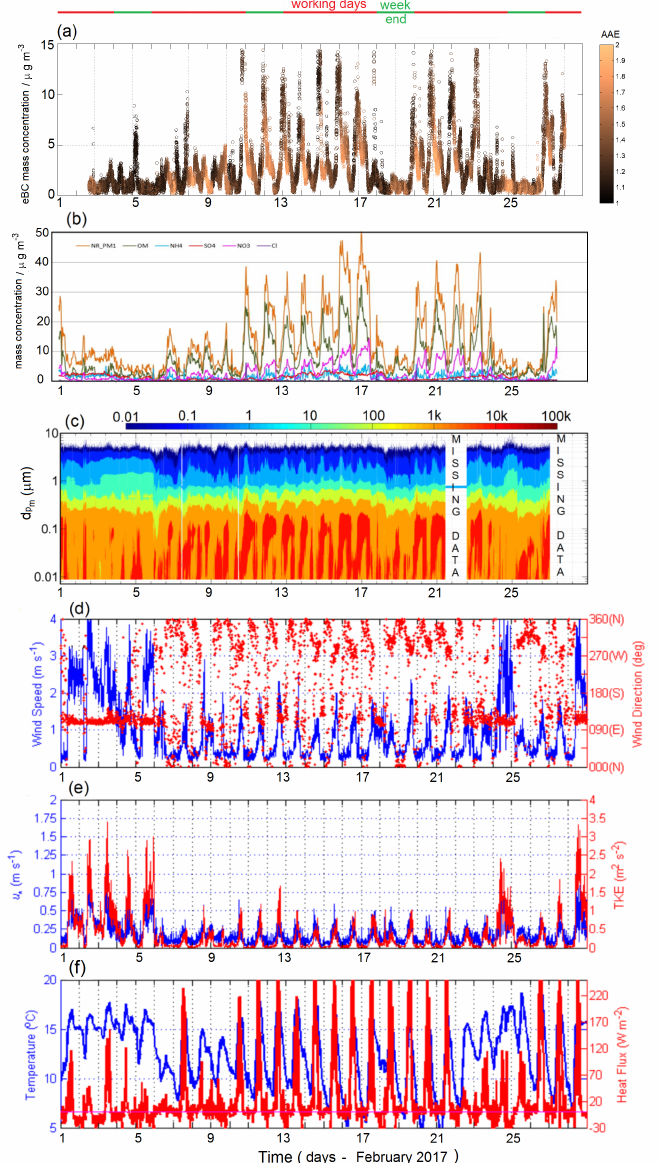
Figure 2. Time series of ( a ) equivalent black carbon (eBC) mass concentration and absorption Ångström Exponent (color); ( b ) mass concentration of major components of non refractory PM 1 ; ( c ) particle number size distribution; ( d ) wind speed and direction; ( e ) frictional velocity ( u ∗ ) and Turbulent Kinetic Energy (TKE); ( f ) temperature and heat flux at the S. Sisto site in Rome from 1 to 28 of February